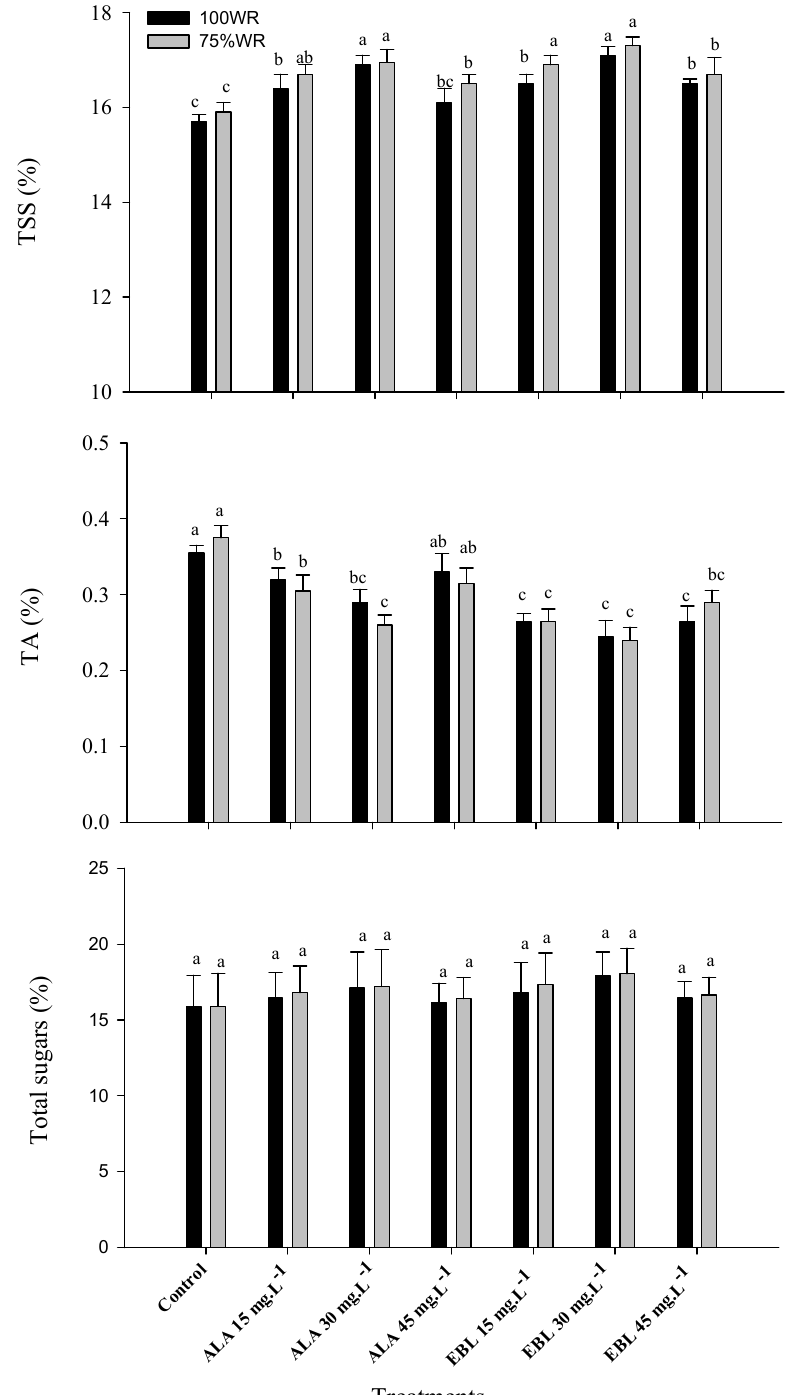
Figure 5. Effect of foliar spray with ALA or EBL on the percentage of total soluble solids (TSS), total acidity (TA) and total sugars in the fruit of drought-stressed “Williams” banana plants during the 2018/2019 and 2019/2020 seasons ( n = 5). The results are the averages of both seasons, and DMRT was used for mean comparisons of treatments under each WR level ( p ≤